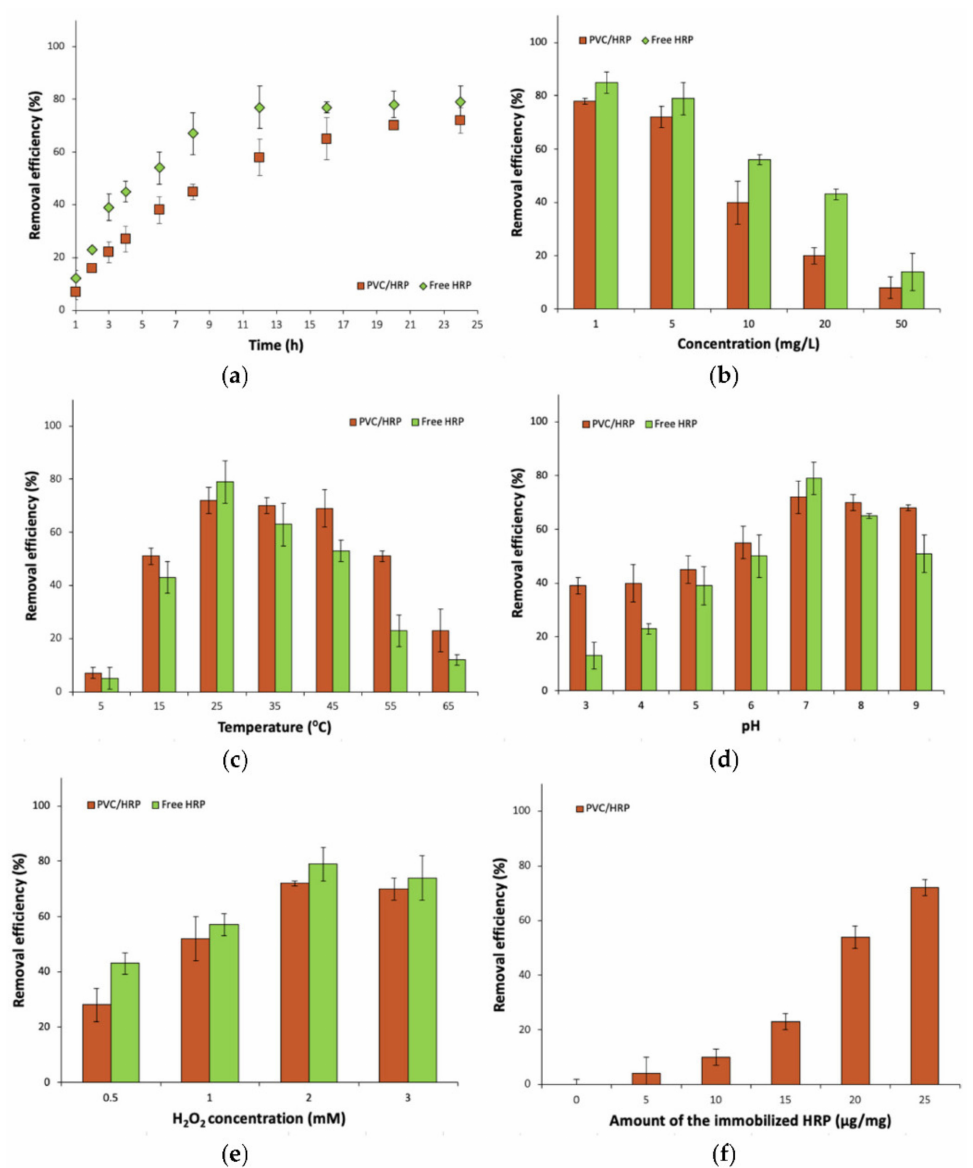
Figure 4. The effect of: ( a ) time process; ( b ) concentration of CBZ; ( c ) temperature; ( d ) pH; ( e ) H 2 O 2 concentration and ( f ) amount of the immobilized HRP on CBZ removal